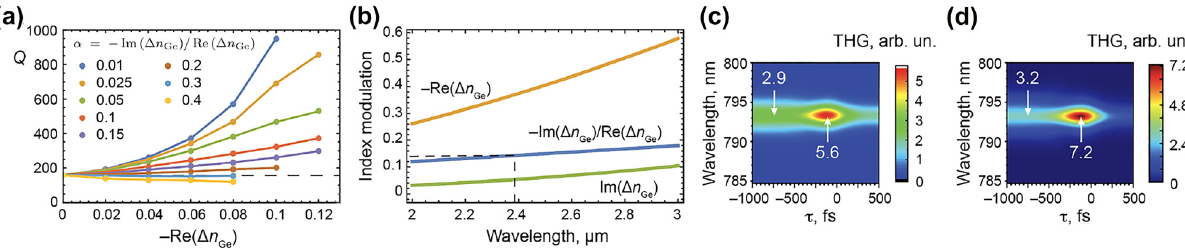
Figure 5: Q-boost in a lossy metasurface. (a) Q-factor of a metasurface with free-carrier losses as a function of Re( Δ n change of the resonance Q-factor is net-positive. (b) Reference data on Re( Δ n = 1.32 × 10 14 s − 1 and free carrier damping frequency Γ = 9.4 × 10 13 s − 1 [51]. 𝛼 = 0.14 at the wavelength of 2.38 μ m. (c) THG frequency of 𝜔 pl spectrum as a function of the control–excitation delay for Re( Δ n 5.6 ∕ 2.9 ≈ 1.9. Here, the Q-boost is Q +∞ ∕ Q −∞ = 1.9. (d) Same for the Q-boost of Q +∞ ∕ Q −∞ = 3; the THG enhancement is 7.2 ∕ 3.2 ≈